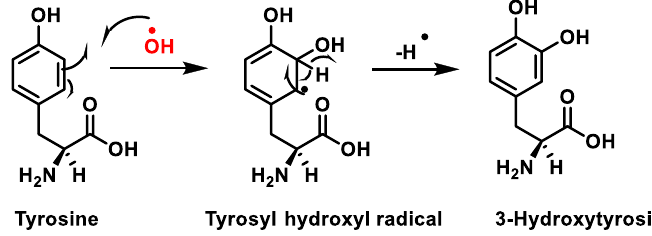
Figure 7. Tyrosine oxidation with hydroxyl radical • OH to hydroxytyrosine. Protein nitration in tyrosine residue is a covalent protein modification from the